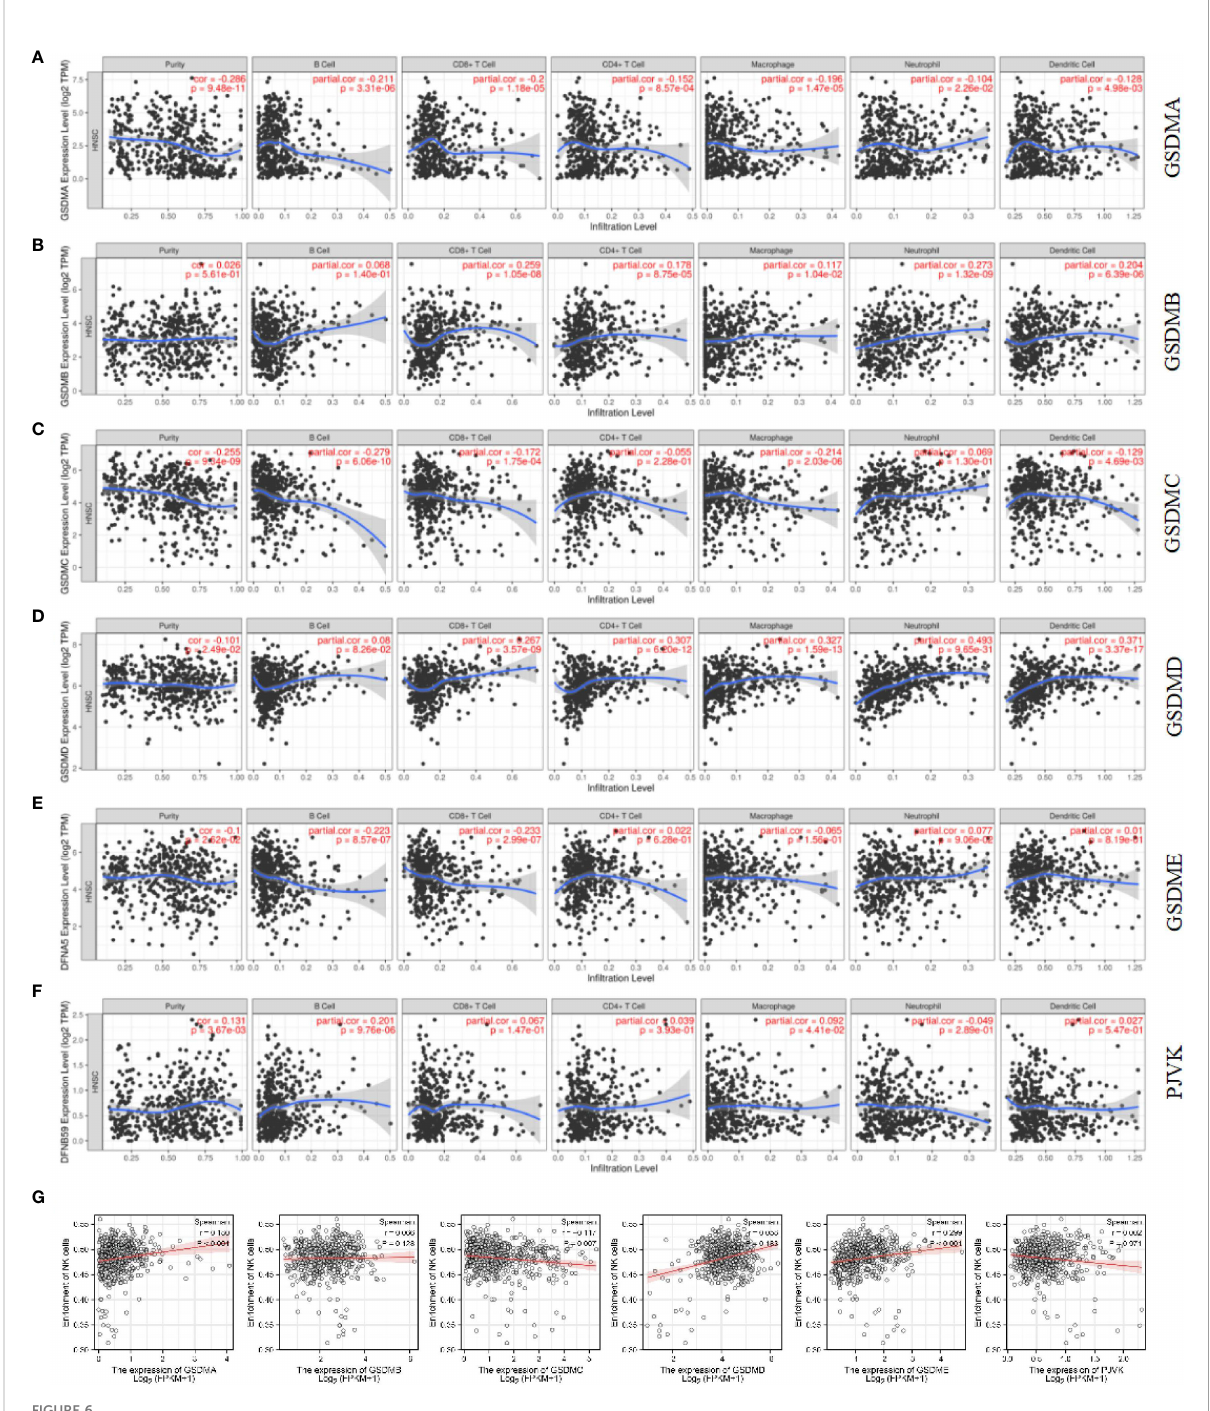
FIGURE 6 Correlation between immune cell in fi ltration and GSDM mRNA expression levels. The TIMER database was used to evaluate the association of GSDMA (A) , GSDMB (B) , GSDMC (C) , GSDMD (D) , GSDME (E) , and PJVK (F) expression and immune cell in fi ltration. The ssGSEA method from R package GSVA was used to evaluate the association of six GSDM family members and NK cell (G)